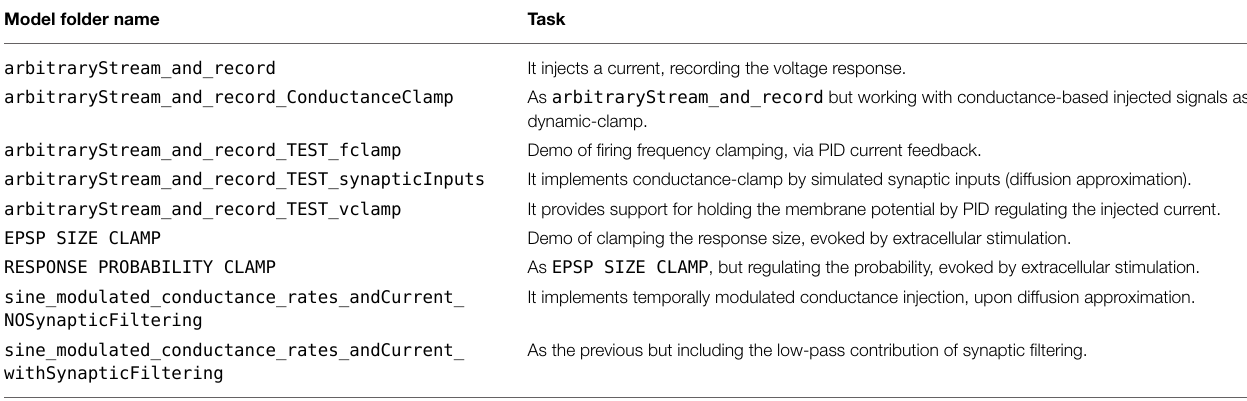
TABLE 2 | Demonstrator models provided with the